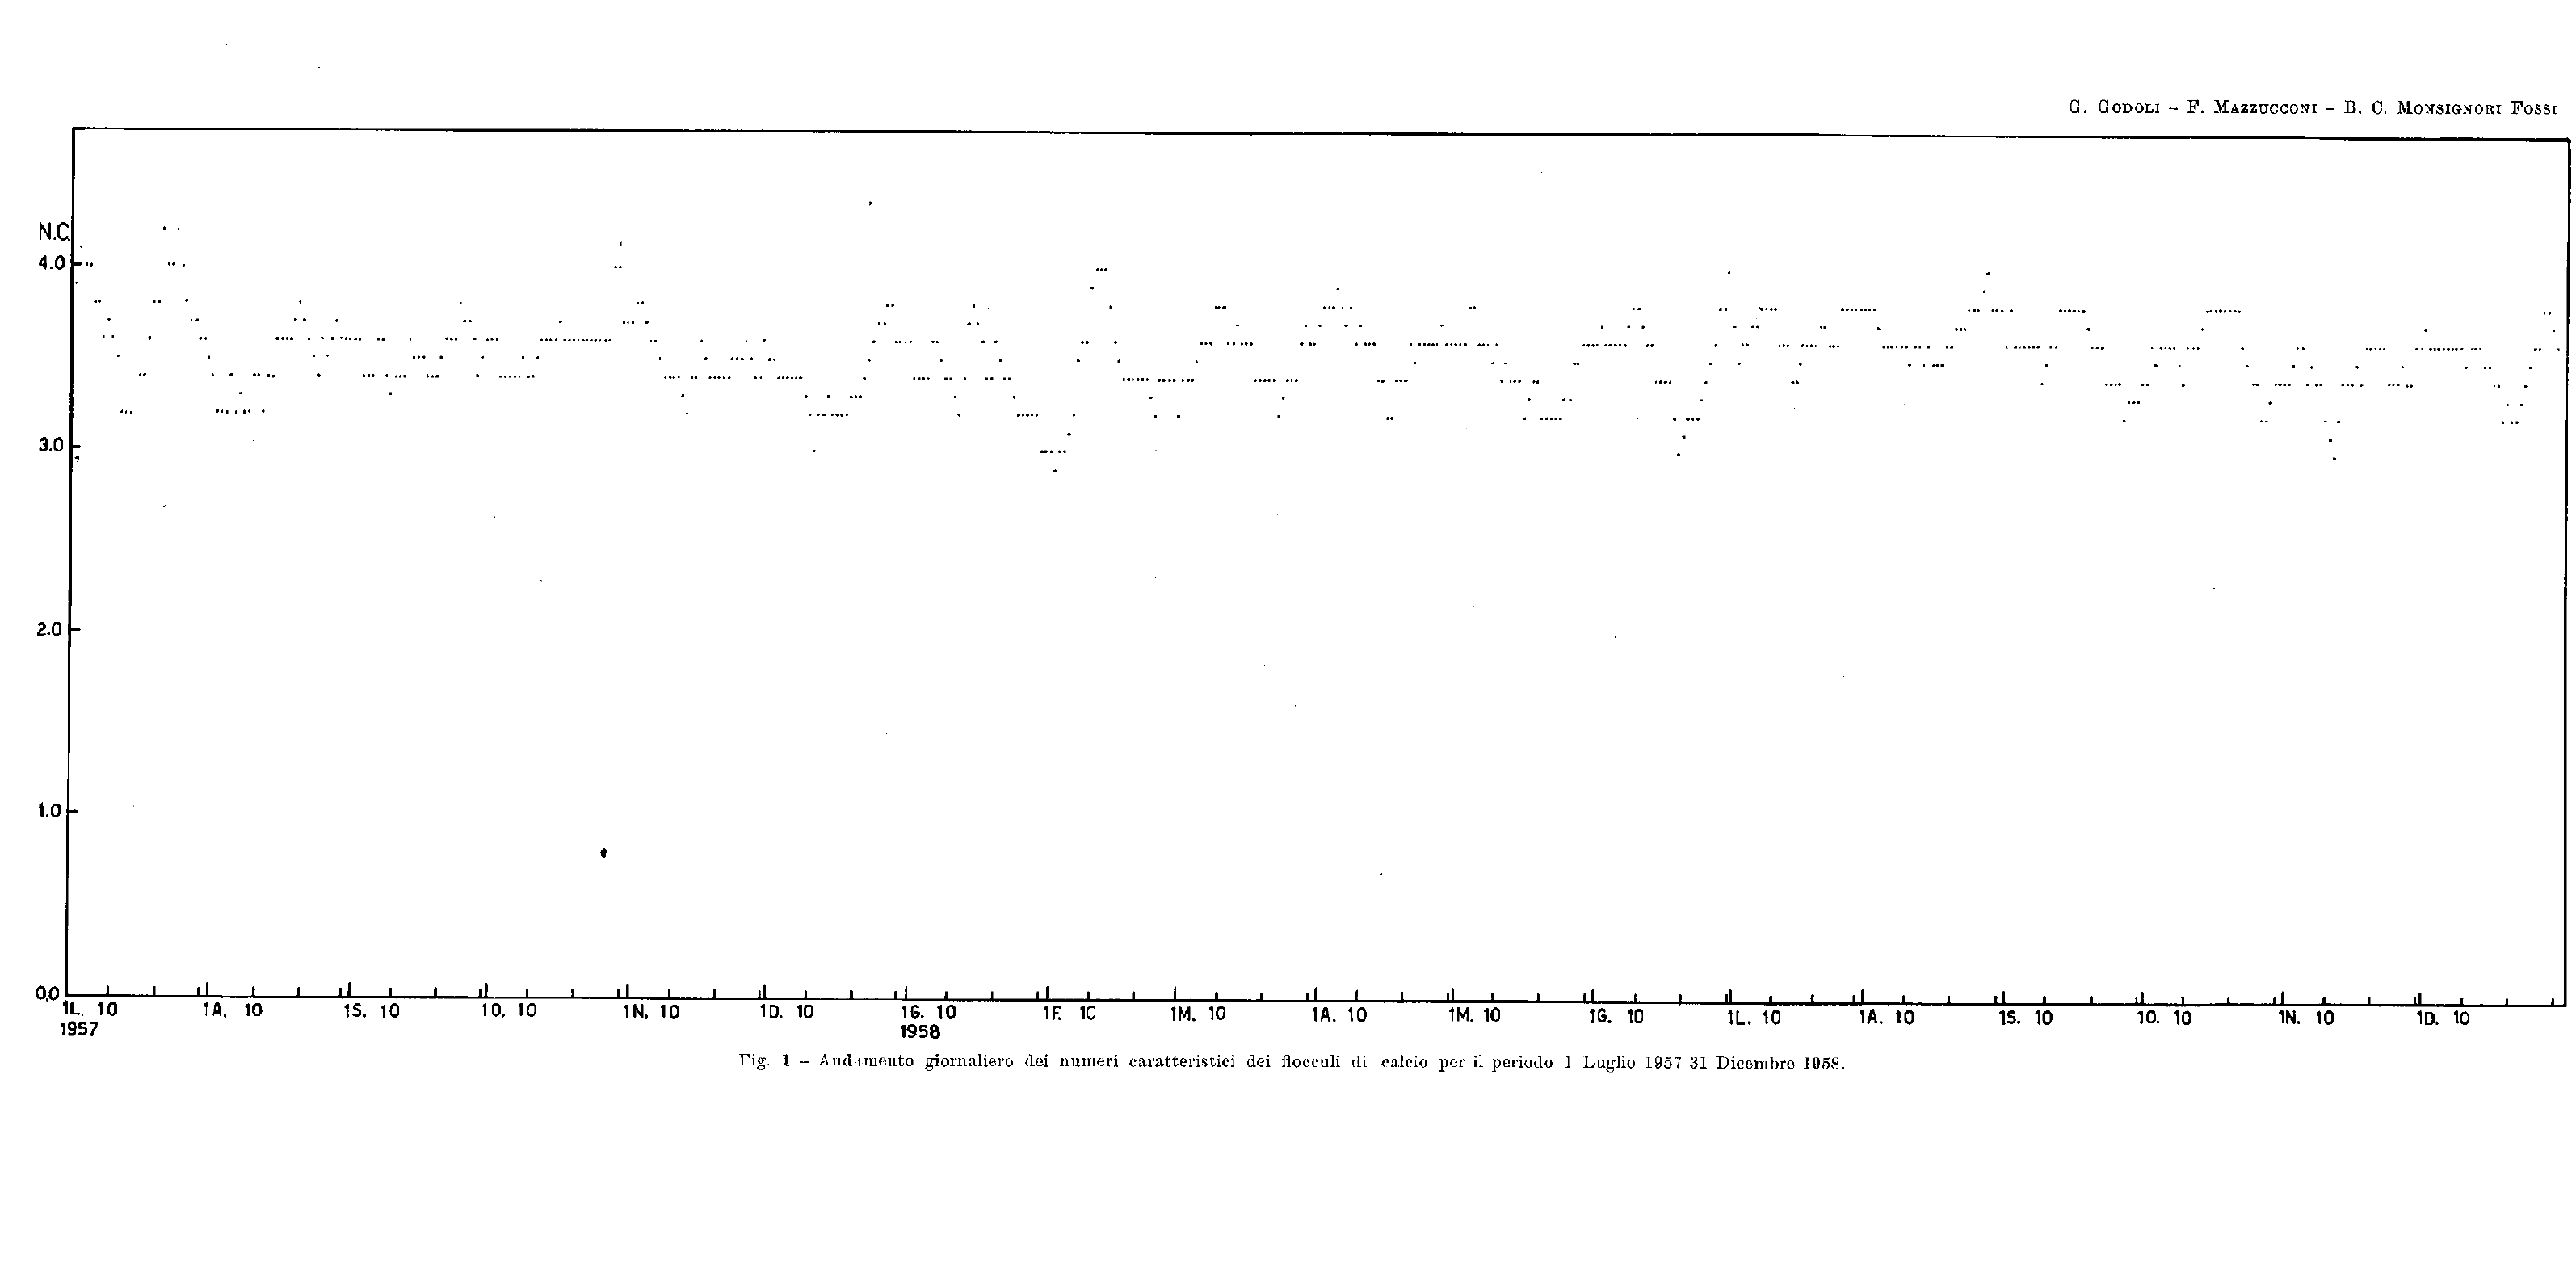
Fig. 1 - Andamento giornaliero dei numeri caratteristici dei flocculi di calcio per il periodo 1 Luglio 1957-31 Dicembre